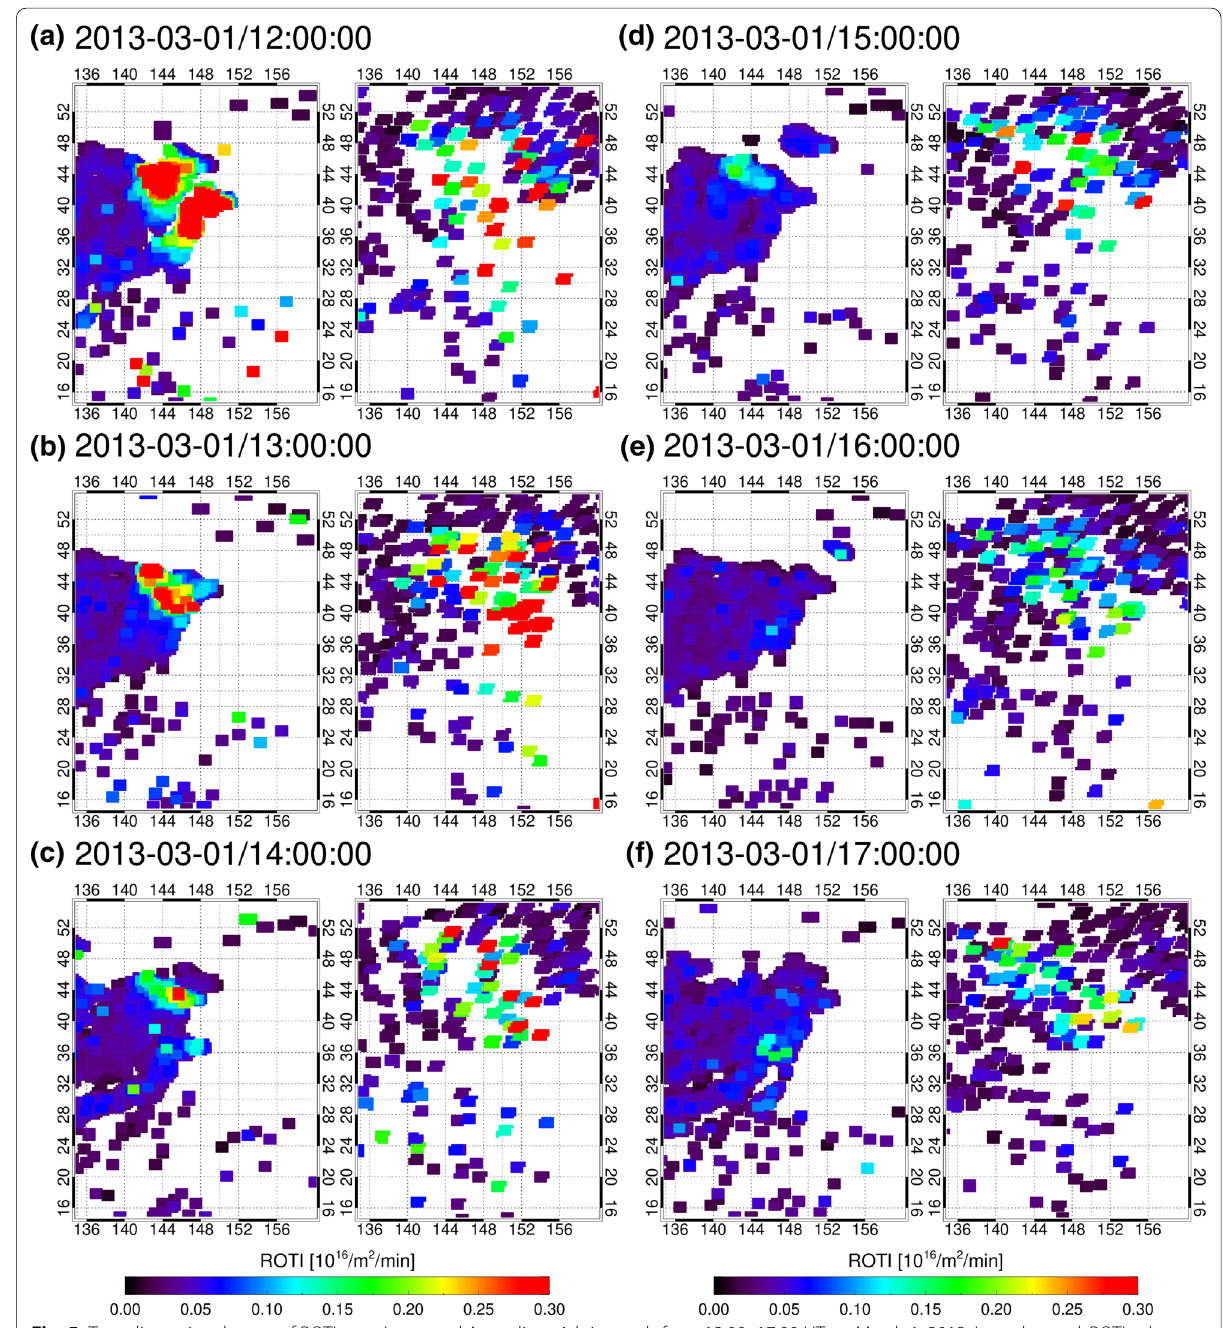
Fig. 5 Two-dimensional maps of ROTI near Japan and Australia at 1-h intervals from 12:00–17:00 UT on March 1, 2013. In each panel, ROTI values over Japan are shown on the left while those over Australia mapped onto the northern hemisphere along the magnetic field lines using the IGRF-13 model are shown on the right. The color code indicates the ROTI value within a range of 0.0 to 0.3